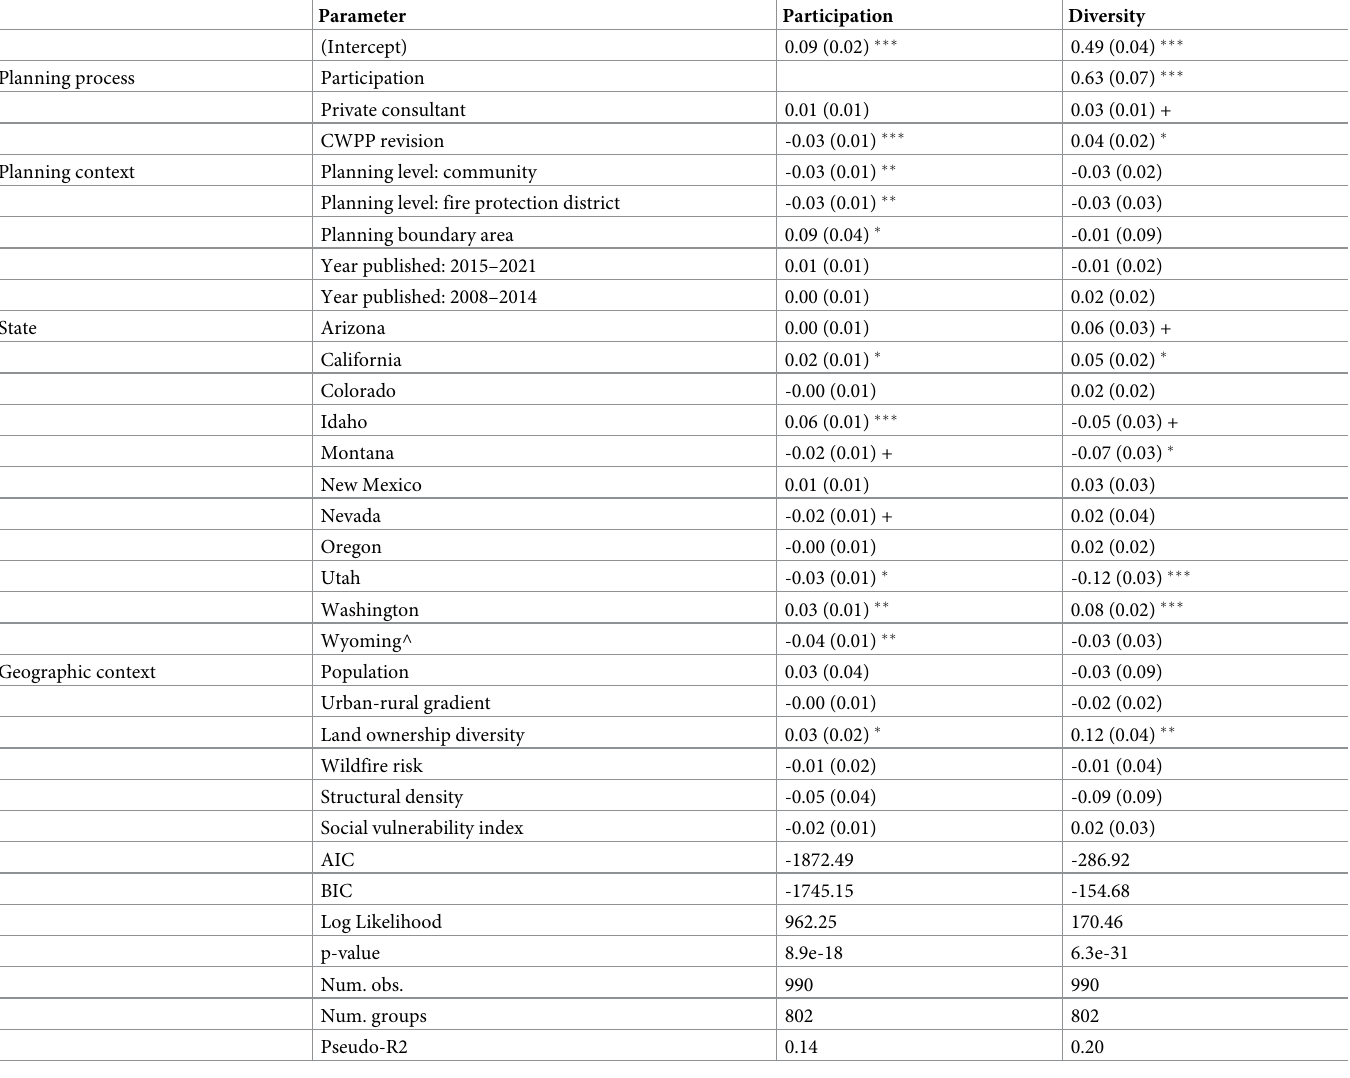
Table 3. Predictors of participation and diversity in